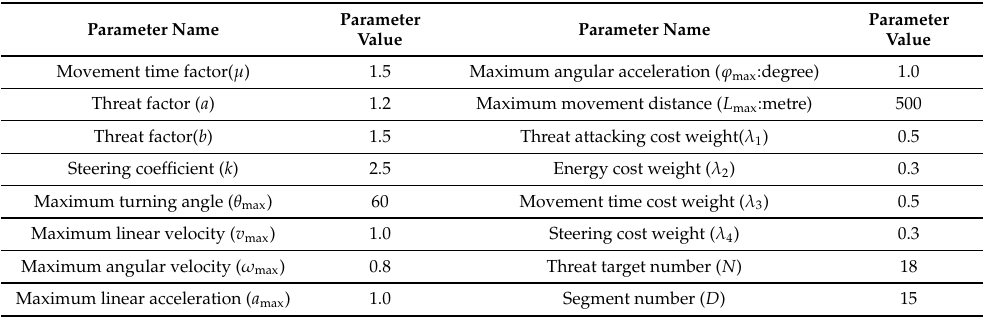
Table 5. Parameters settings for path